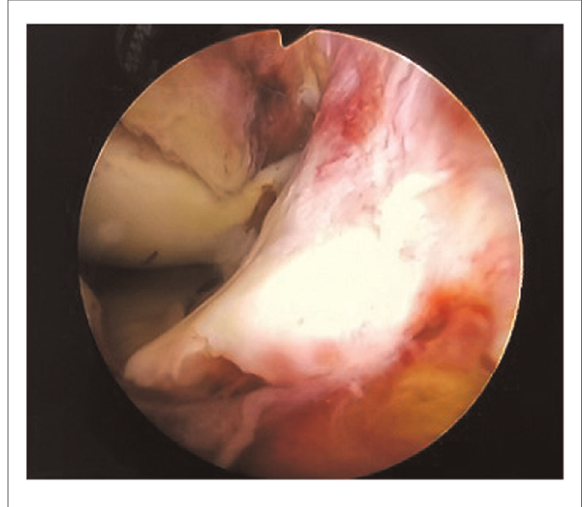
FIGURE 1 Arthroscopic view: type III fracture with ligament being obstacle to reduction.